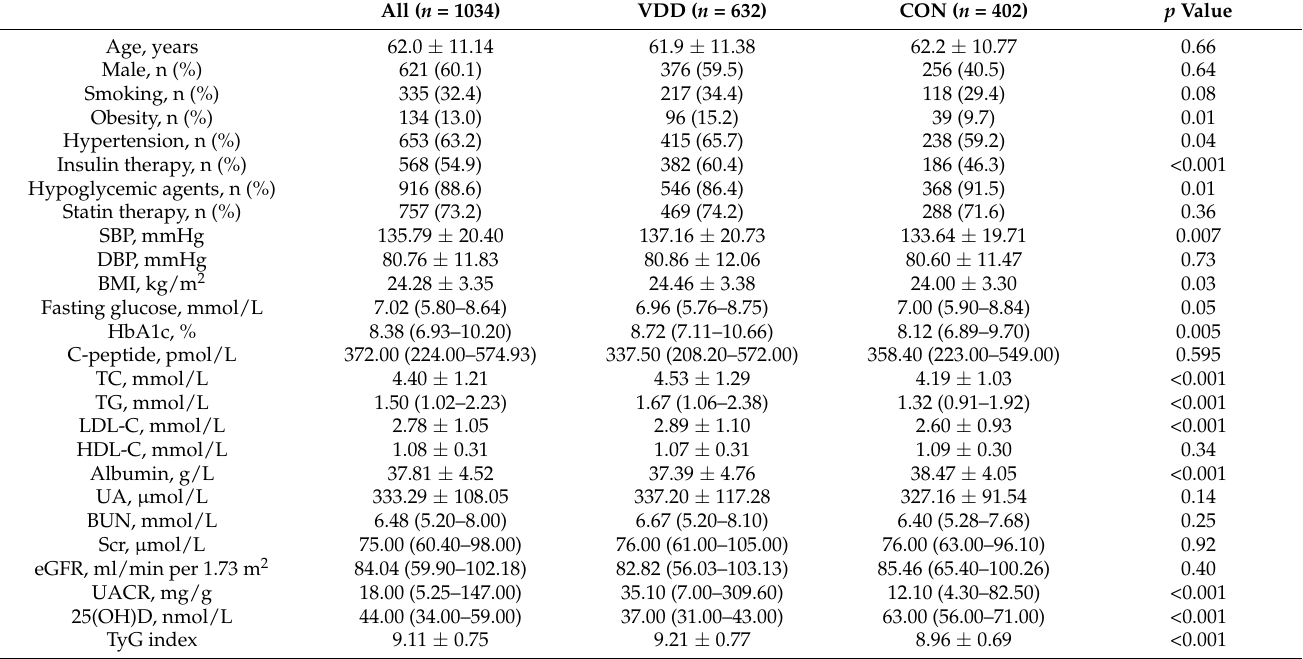
Table 2. Spearman’s correlation between TyG index and glycolipid-metabolic risk factors.